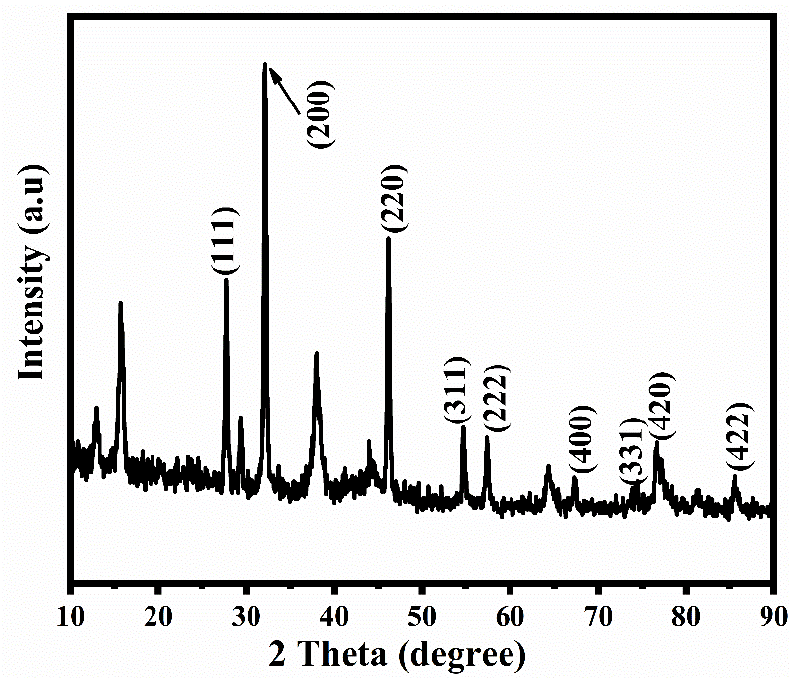
Figure 2. XRD analysis of biogenic AgNPs showing three distinct peaks, representing Bragg reflec- tions of 27.9 ° , 32.3 ° , 47.5 ° , 55.0 ° , 57.8 ° , 67.6 ° , 74.6 ° , 76.9 ° and 85.7 ° .